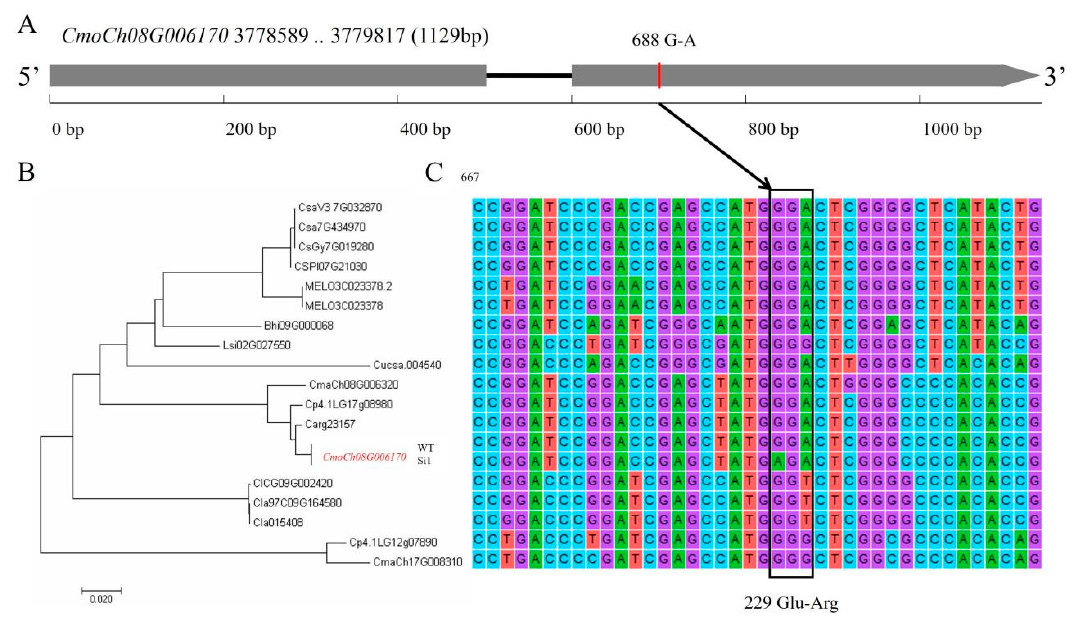
Figure 4. Gene structure, phylogenetic analysis, and sequence alignment of the CmaSI1 gene in pumpkin. ( A ) The genomic structure of the predicted CmaSI1 gene in pumpkin. The SNP presents a single nucleotide substitution from G to A that occurs in the second exon. ( B ) Phylogenetic analysis of CmaSI1 proteins and their homologs in Cucurbitaceae species. ( C ) Sequence alignment of the CmaSI1 gene and its homologs. Nucleotide site 688 in CmoCh08G006170 in all homologous genes presented a G, resulting in the highly conserved amino acid Glu.